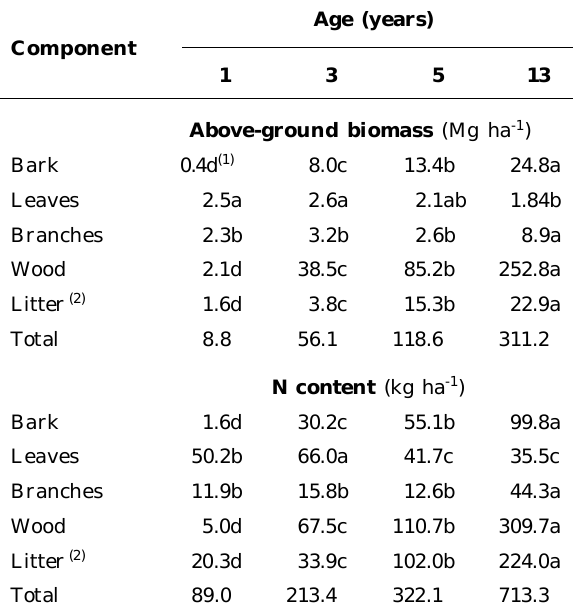
Table 1. Above-ground biomass and N content from different compartments of eucalyptus in an